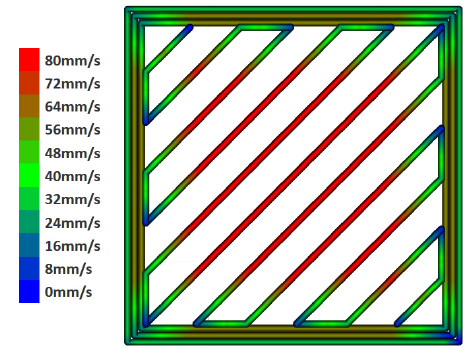
Figure 3. Visualization of the printer head speed during processing of a single layer assuming the trape- zoidal velocity